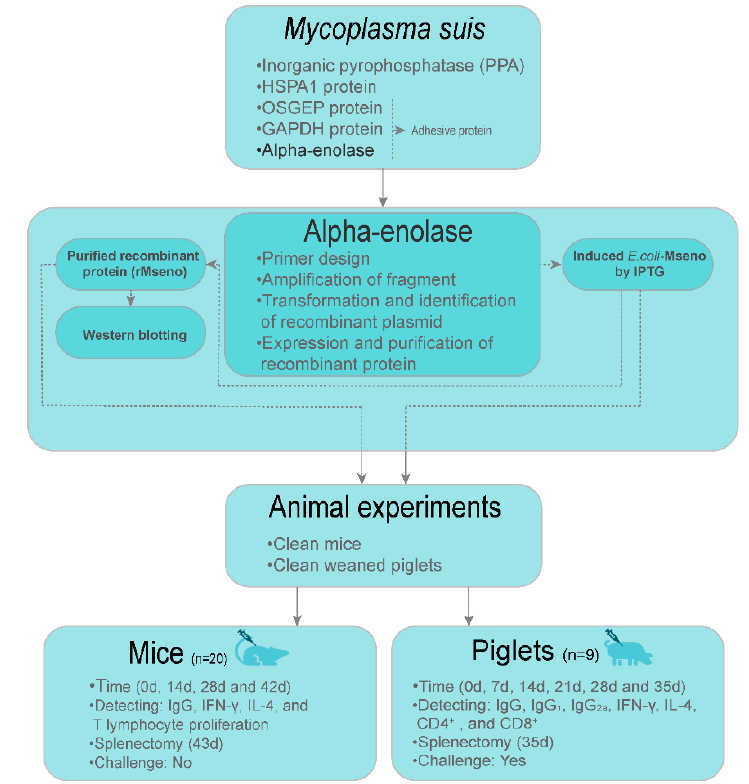
Figure 1. Overall flow.